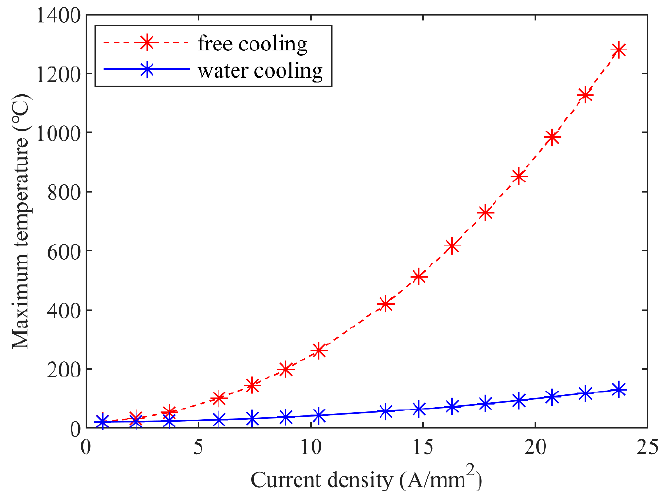
Figure 13. The relationship between maximum temperature and current density.